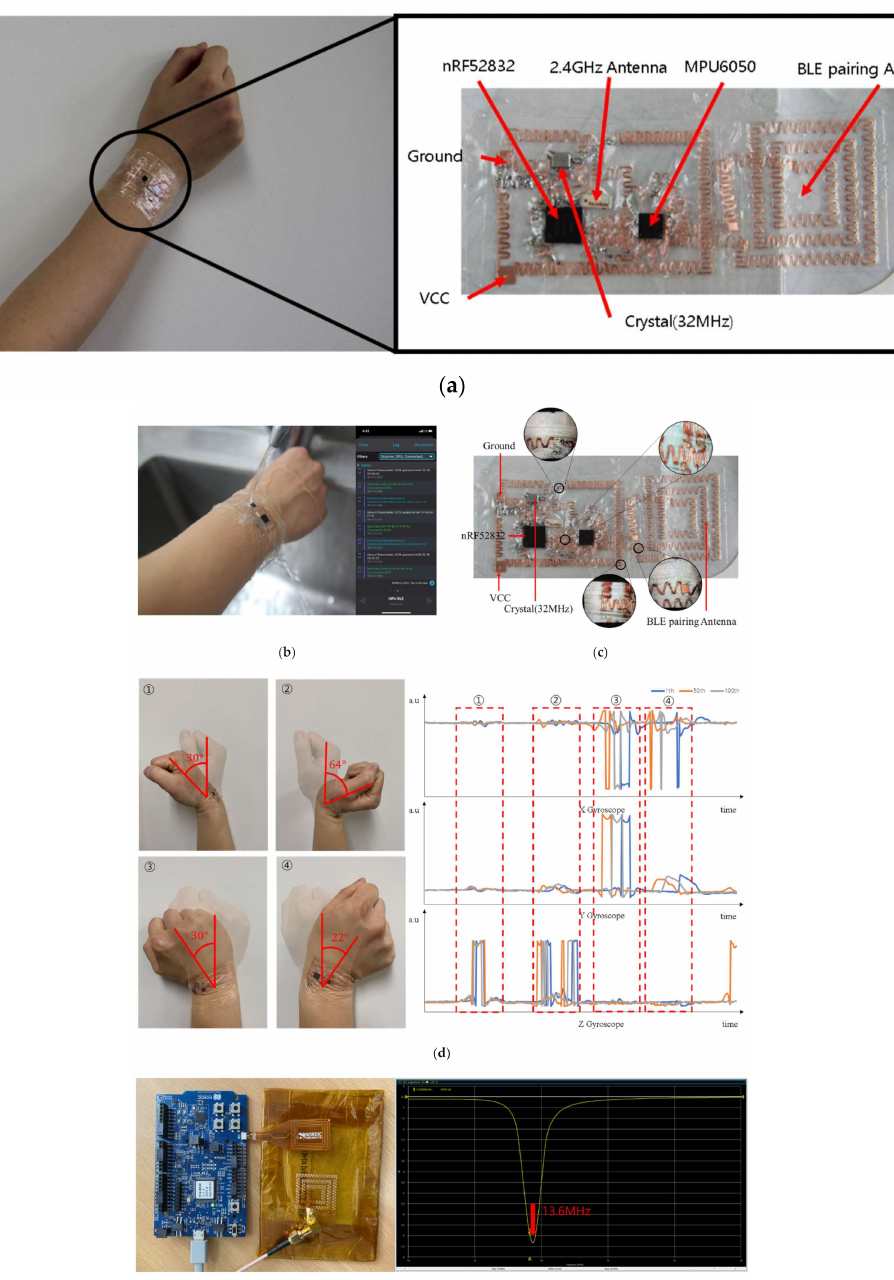
Figure 6. Implementation results. ( a ) Wireless epidermal six-axis IMU; ( b ) waterproof experimental results; ( c ) stretchability test results with 30% tensile strain; ( d ) wrist bending experimental results after first, 50th and 100th repetitions; ( e ) Bluetooth low energy (BLE) paring antenna measurement result in free